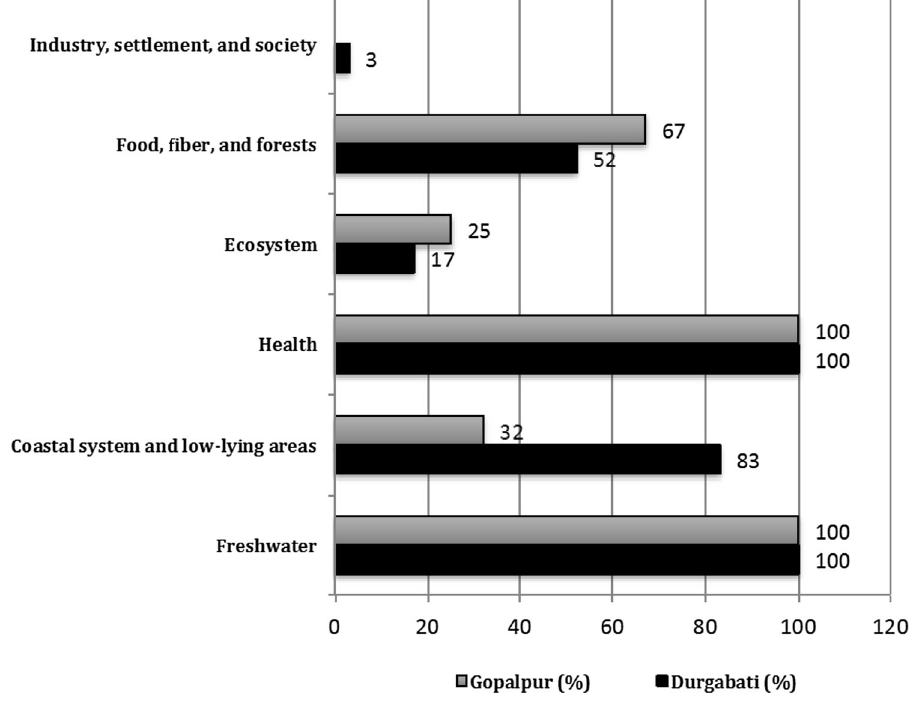
Fig. 5 Climatic causes of